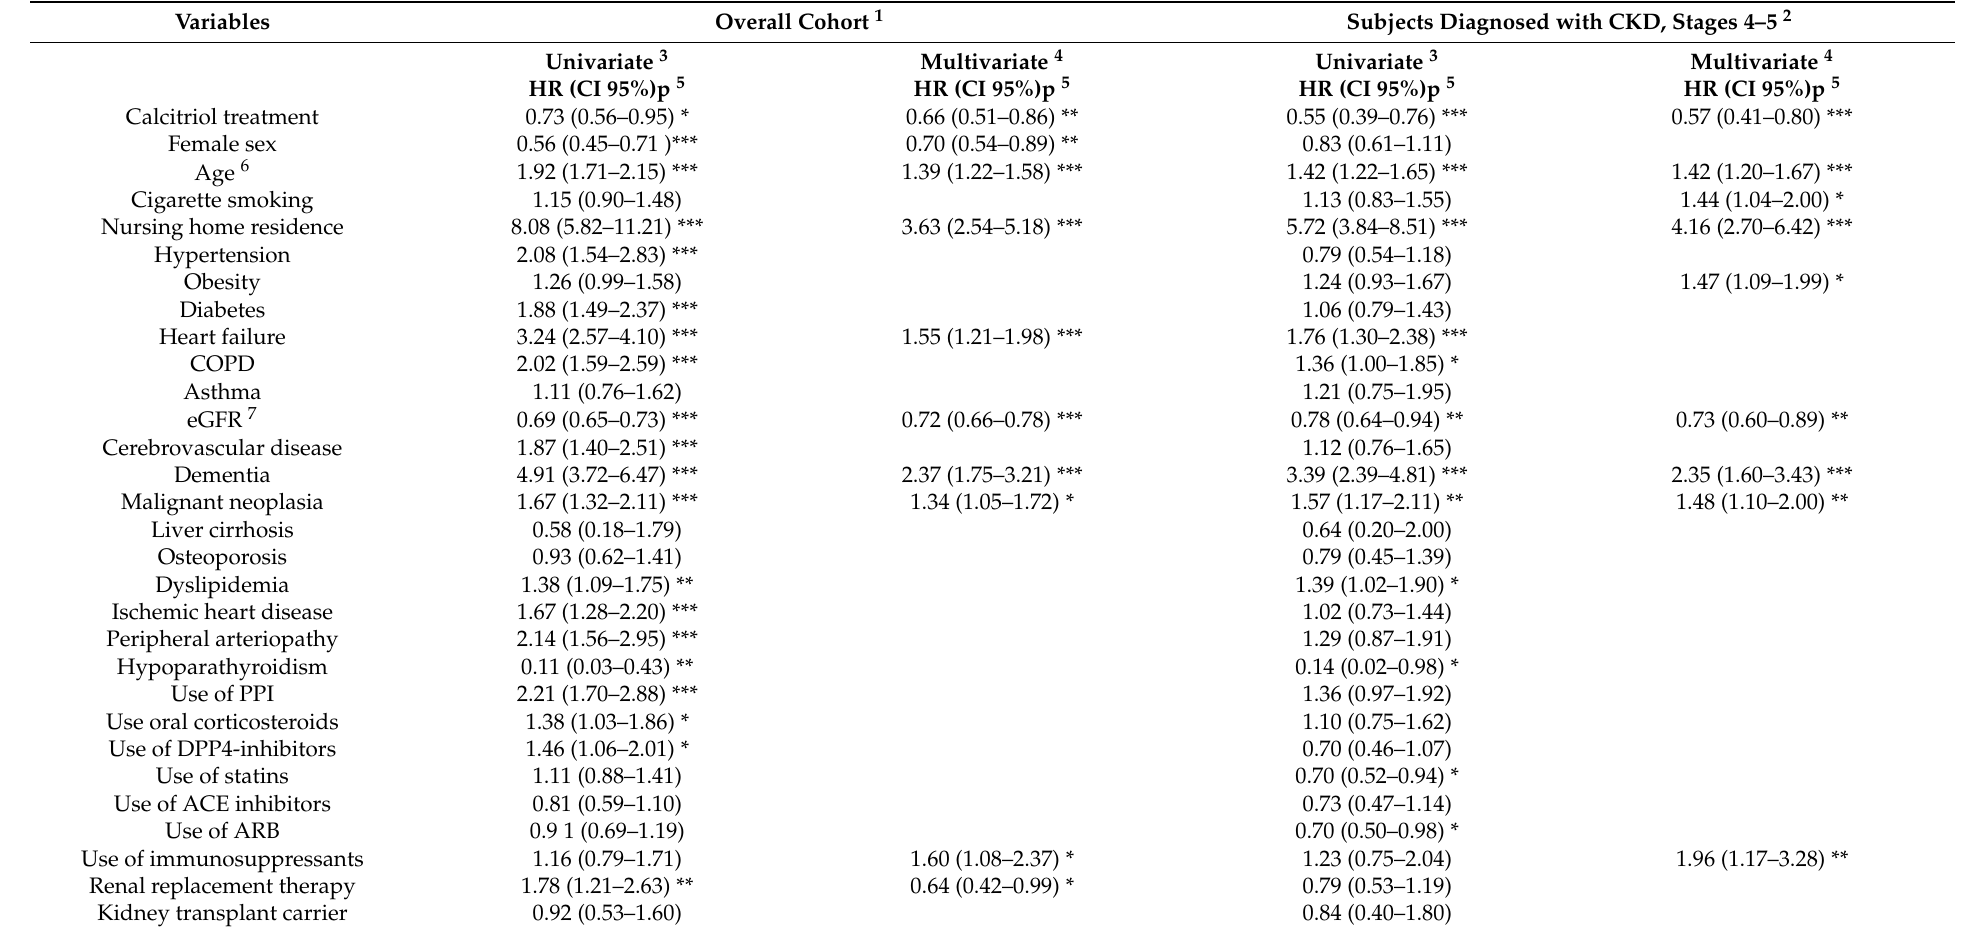
Table 5. Variables associated with COVID-19 mortality in patients on calcitriol treatment and matched